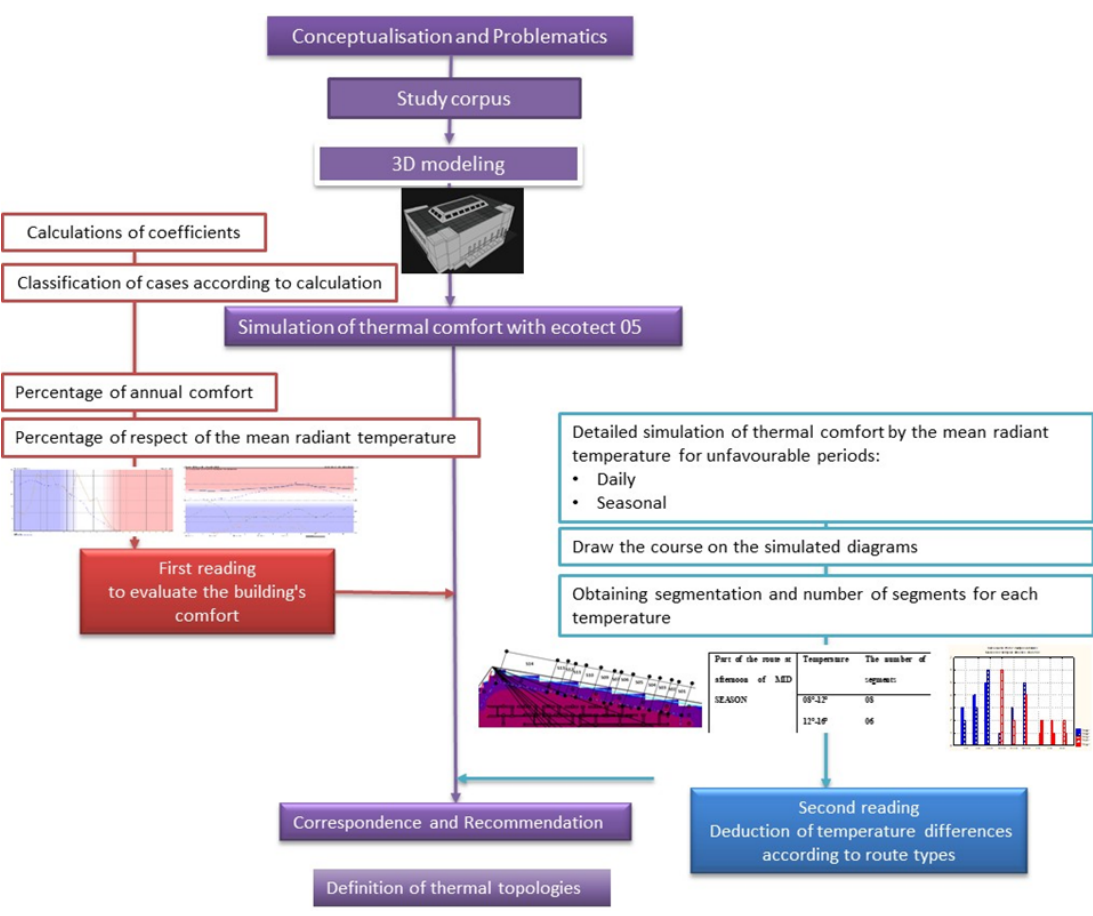
Figure 2: Methodological principle (source: author,